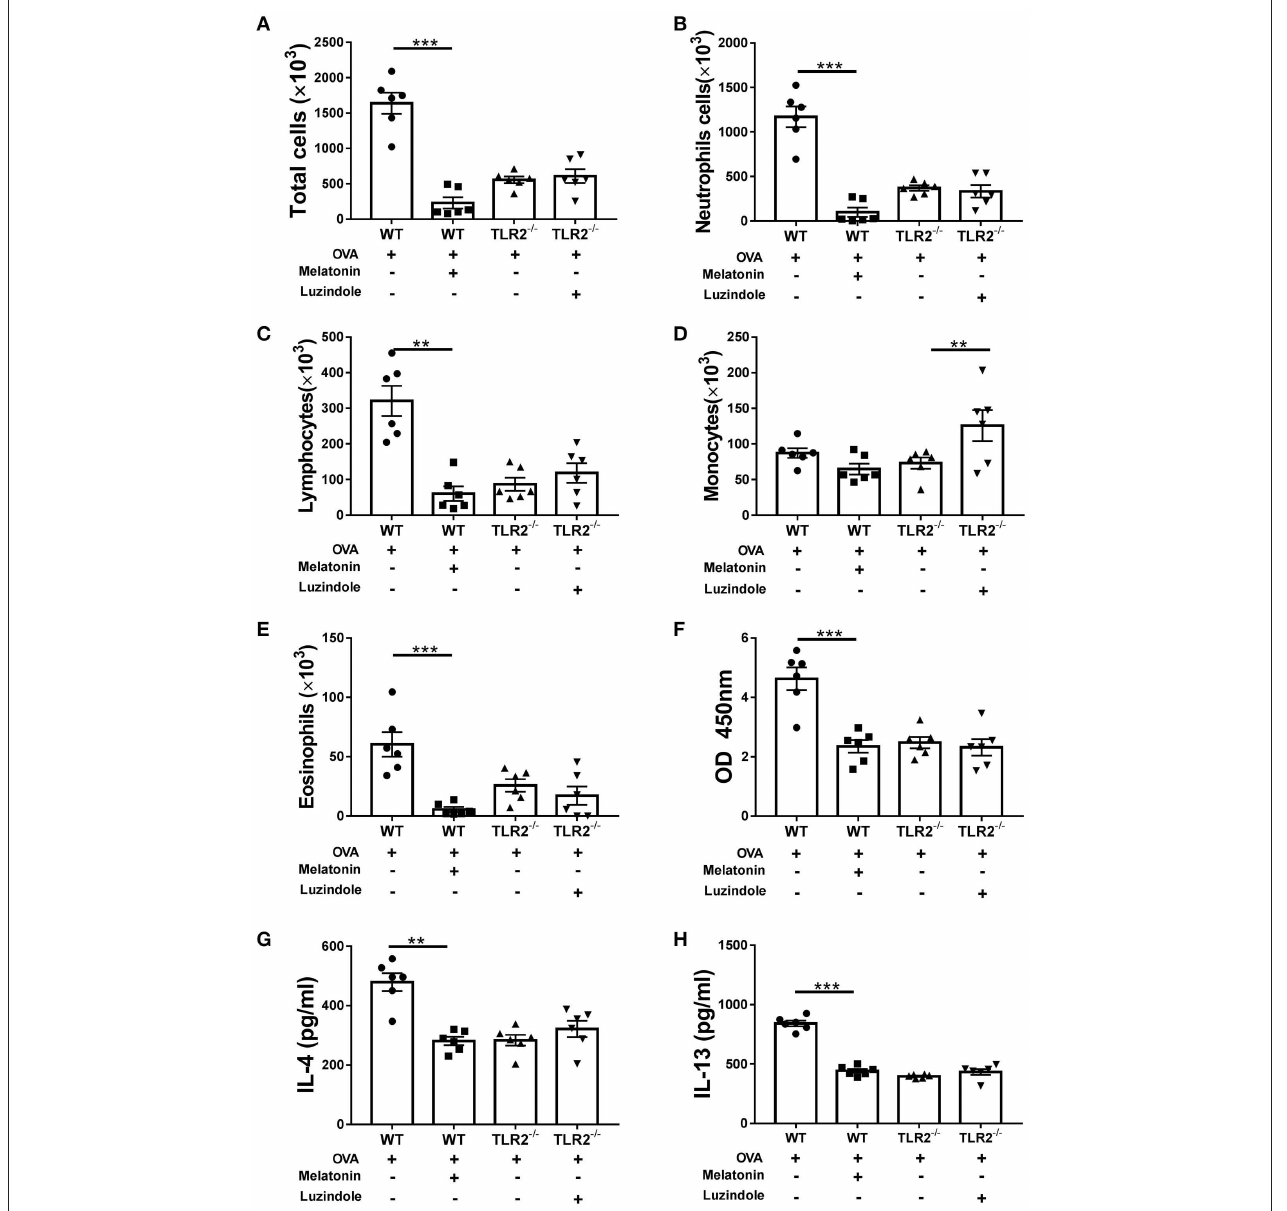
FIGURE 5 | The effect of exogenous melatonin or luzindole on OVA-induced inflammatory cells infiltration, IgE and Th2 cytokines production. (A–E) Analysis of total and differential cells found in BALF of OVA-challenged WT or TLR2 − / − mice after melatonin or luzindole treatment, respectively. (F) The level of OVA-specific IgE in serum. (G,H) The levels of IL-4 and IL-13 in BALF. ** p < 0.01, *** p < 0.001.